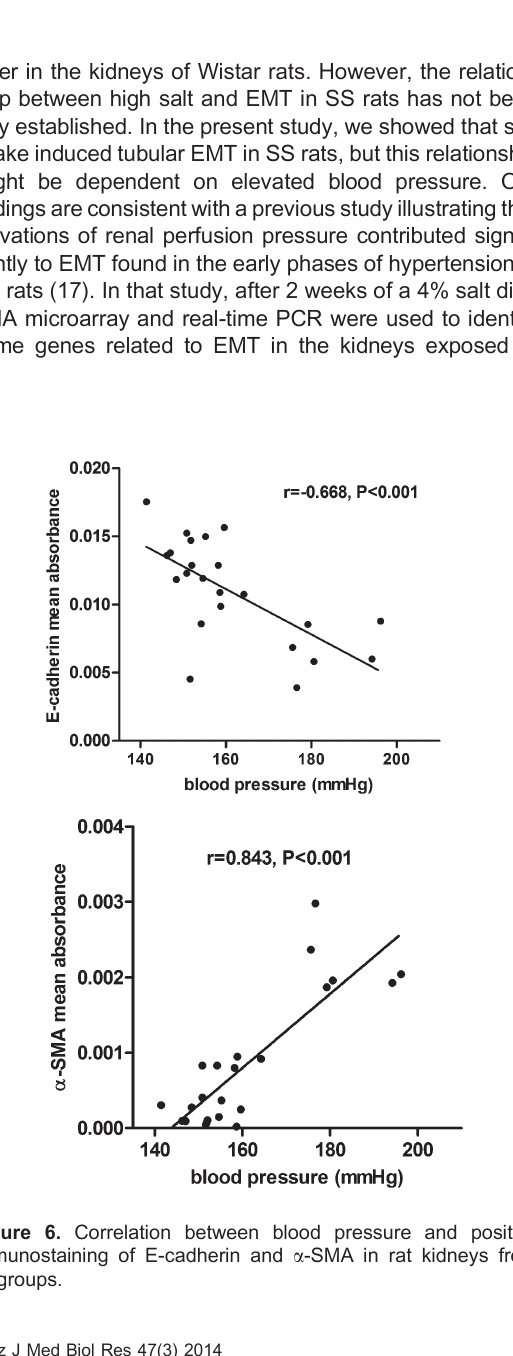
Figure 5. Kidney E-cadherin and a -SMA mRNA expression in all groups. SN: Dahl salt-sensitive (SS) rats on a normal-salt diet (0.3% NaCl); SH: Dahl SS rats on a high-salt diet (8% NaCl); BN: SS-13 BN rats on a normal-salt diet (0.3% NaCl); BH: SS-13 BN rats on a high-salt diet (8% NaCl). One-wayANOVA wasusedfor statistical